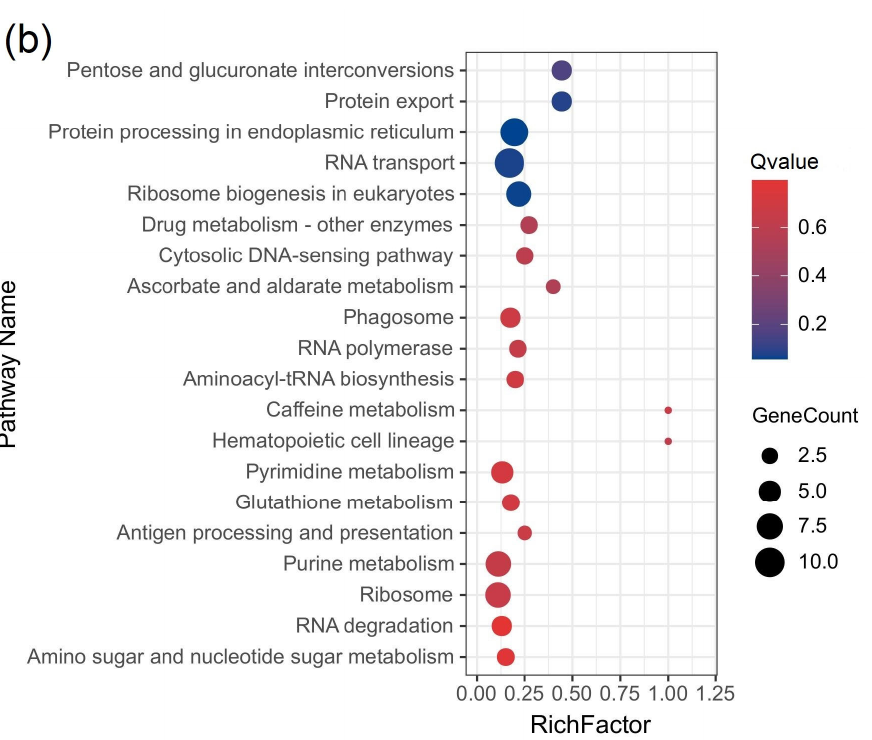
Figure 4. Annotation and enrichment analysis of differentially expressed genes (DEGs) in gregarious armyworms compared with solitary armyworms. ( a ) Column chart of Gene Ontology functional annotation; ( b ) Kyoto Encyclopedia of Genes and Genomes (KEGG) enrichment bubble chart.